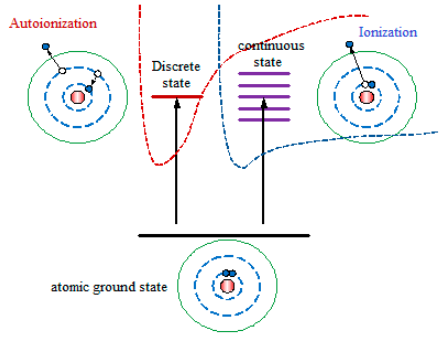
Figure 9. The two modes of the photoionization of atoms.